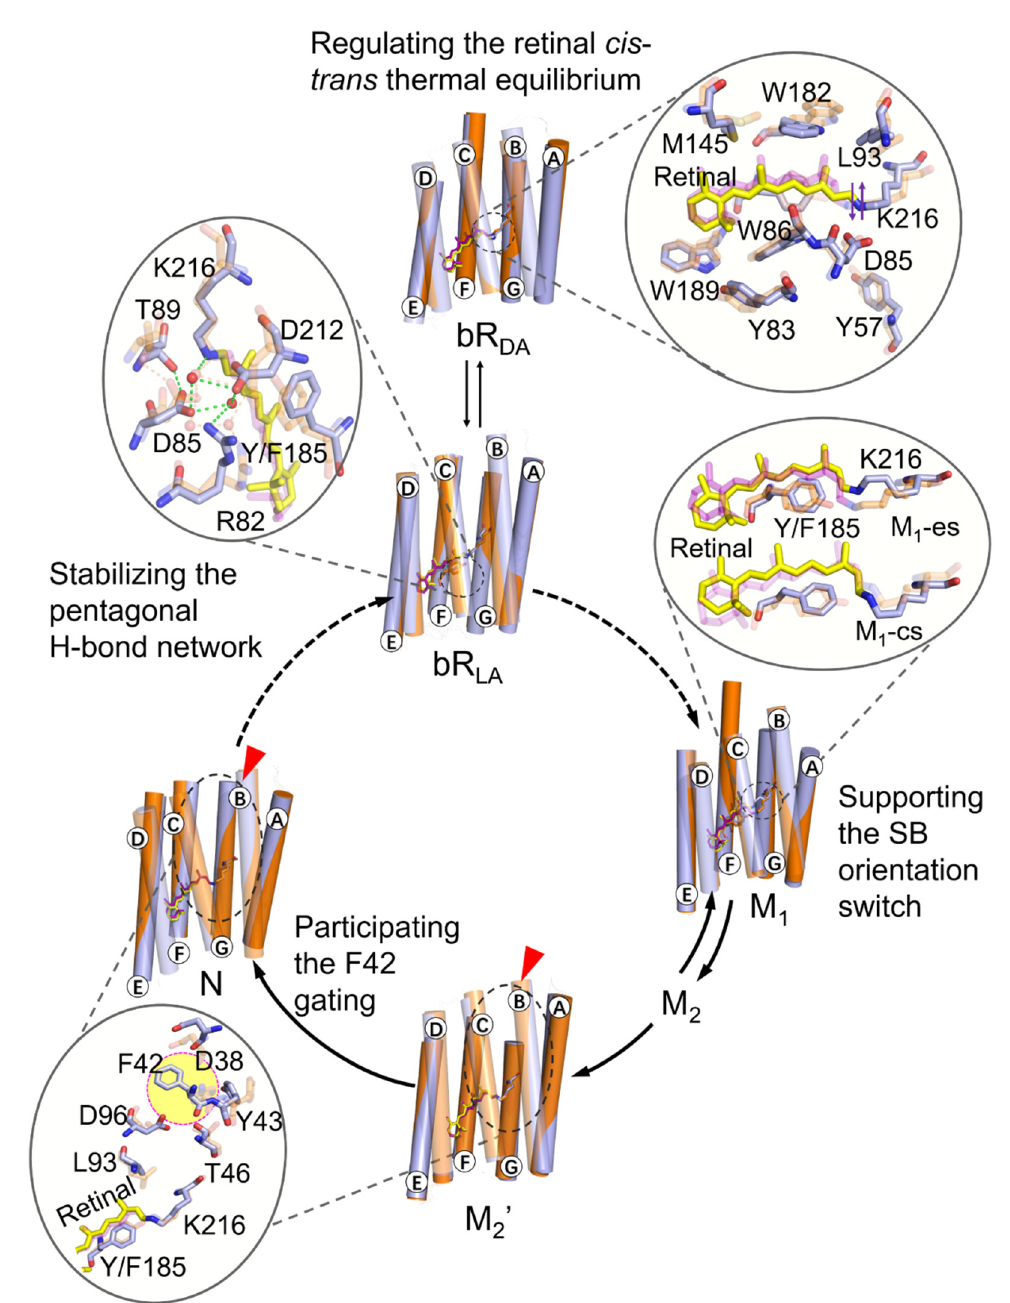
Figure 9. Schematic flowchart of the effects of Y185 on several important events during the bR photocycle. The color coding is the same as in Figure 2E, and the red arrowhead indicates a substantial change in the helix.